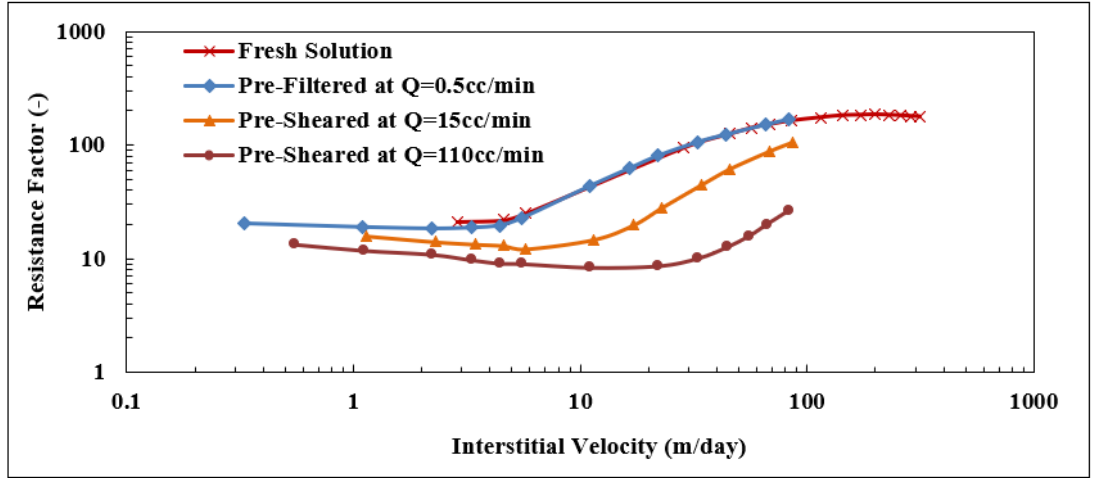
Figure 11. Resistance factor versus interstitial velocity for polymer B presheared at different flow rates.